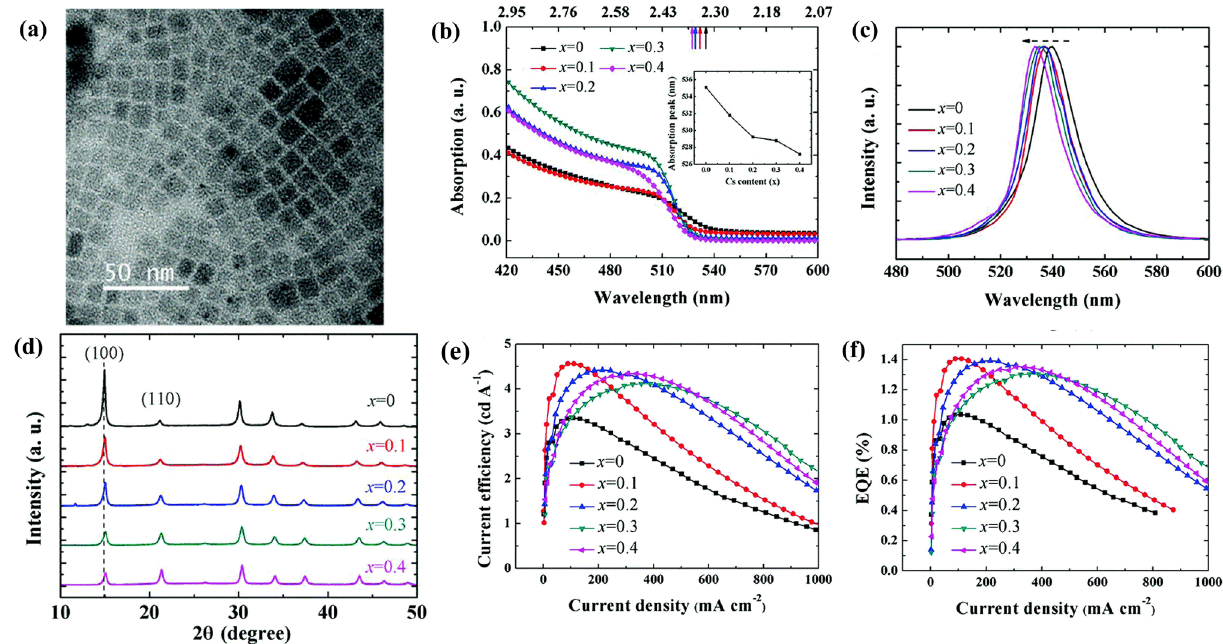
Adapted with permission from ref. [88], copyright 2017, The Royal Cs PbBr NCs. b The absorption 0.7 0.3 3 Society of Chemistry CsxPbBr (x = 0–0.4). 1–x 3